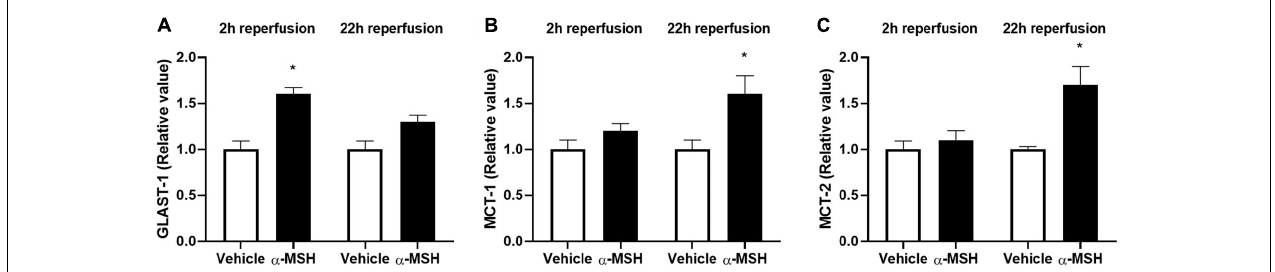
FIGURE 7 | α -MSH increased expression of glutamate and lactate related genes after I/R injury. (A) GLAST-1 expression was significantly higher in animals treated with α -MSH at 2 h of reperfusion. (B,C) MCT-1 and MCT-2 expressions were significantly higher in animals treated with α -MSH at 22 h of reperfusion. (A–C) GLAST-1 expression at 22 h of reperfusion and expressions of MCT-1 and MCT-2 at 2 h of reperfusion were comparable. * P < 0.05, Independent samples t -test, n = 5 for each